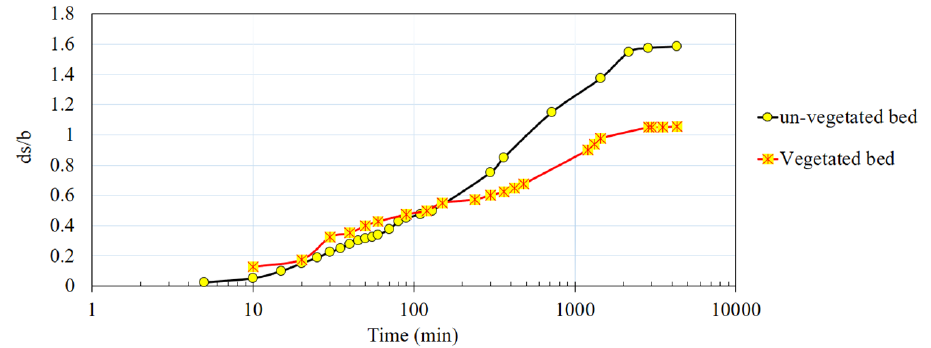
Figure 4. Variation of relative scour depth with time in the front face of the semi-elliptical abutment for both un-vegetated and vegetated beds.